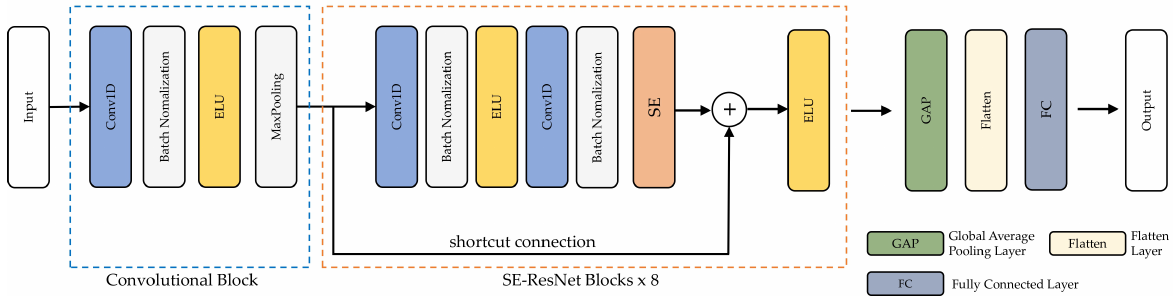
Figure 2. Architecture of the